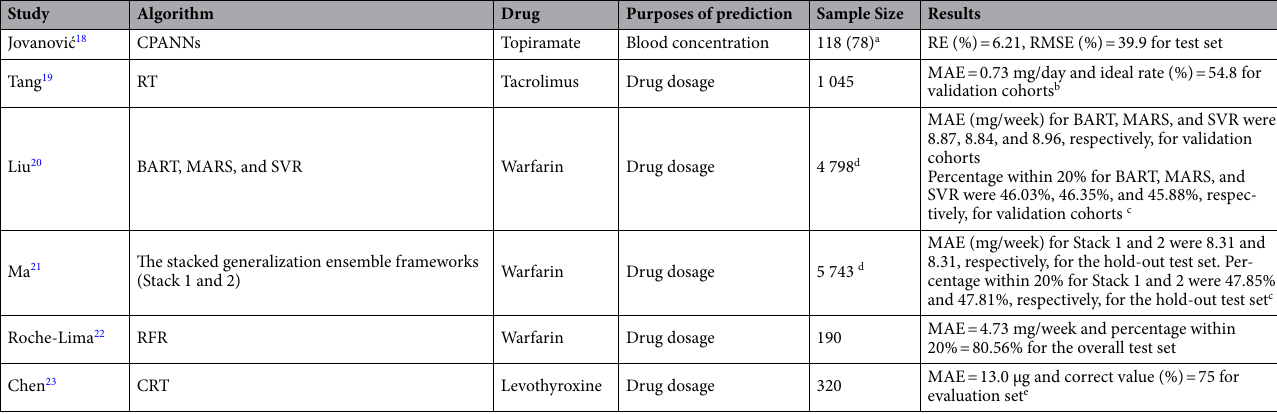
slow drug clearance while a low C/D ratio implies the reverse 7 . The C/D ratio has proven to be a valuable tool to facilitate dosing adjustment because it can be used to identify possible associations between adverse drug reactions and pharmacokinetic parameters 8 , analyze pharmacokinetic variability 9 , measure non-adherence to